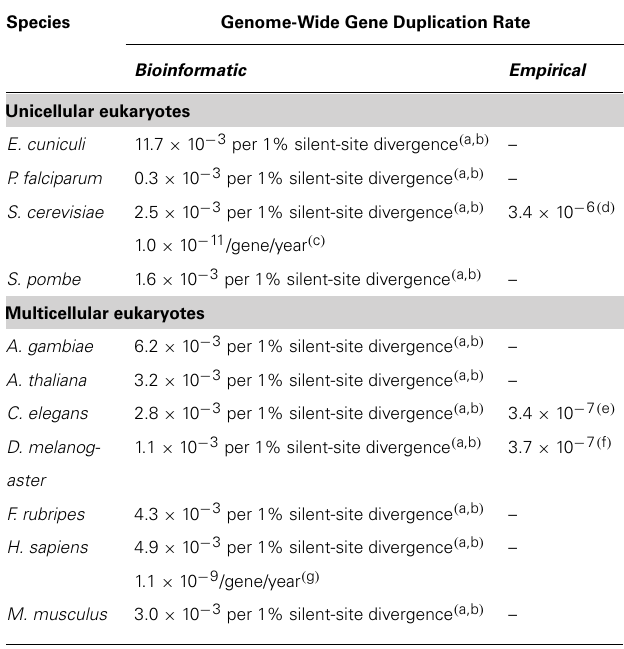
Table 2 | Genome-wide estimates of the duplication rates for prokaryotes and eukaryotes.